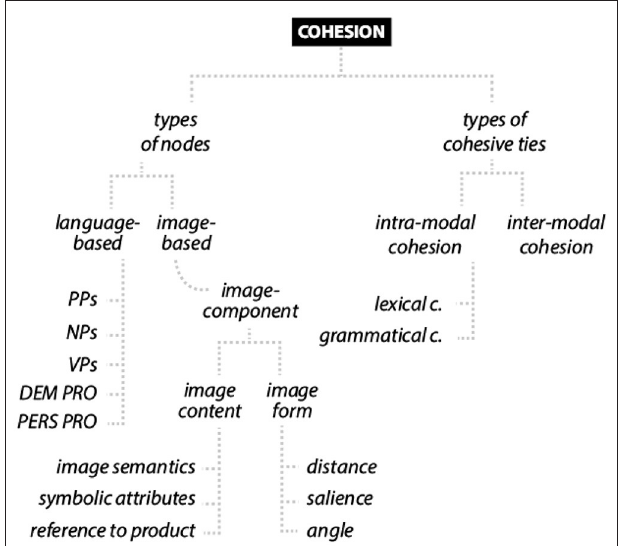
FIGURE 3 | Taxonomic overview of concepts for an analysis of cohesion in print